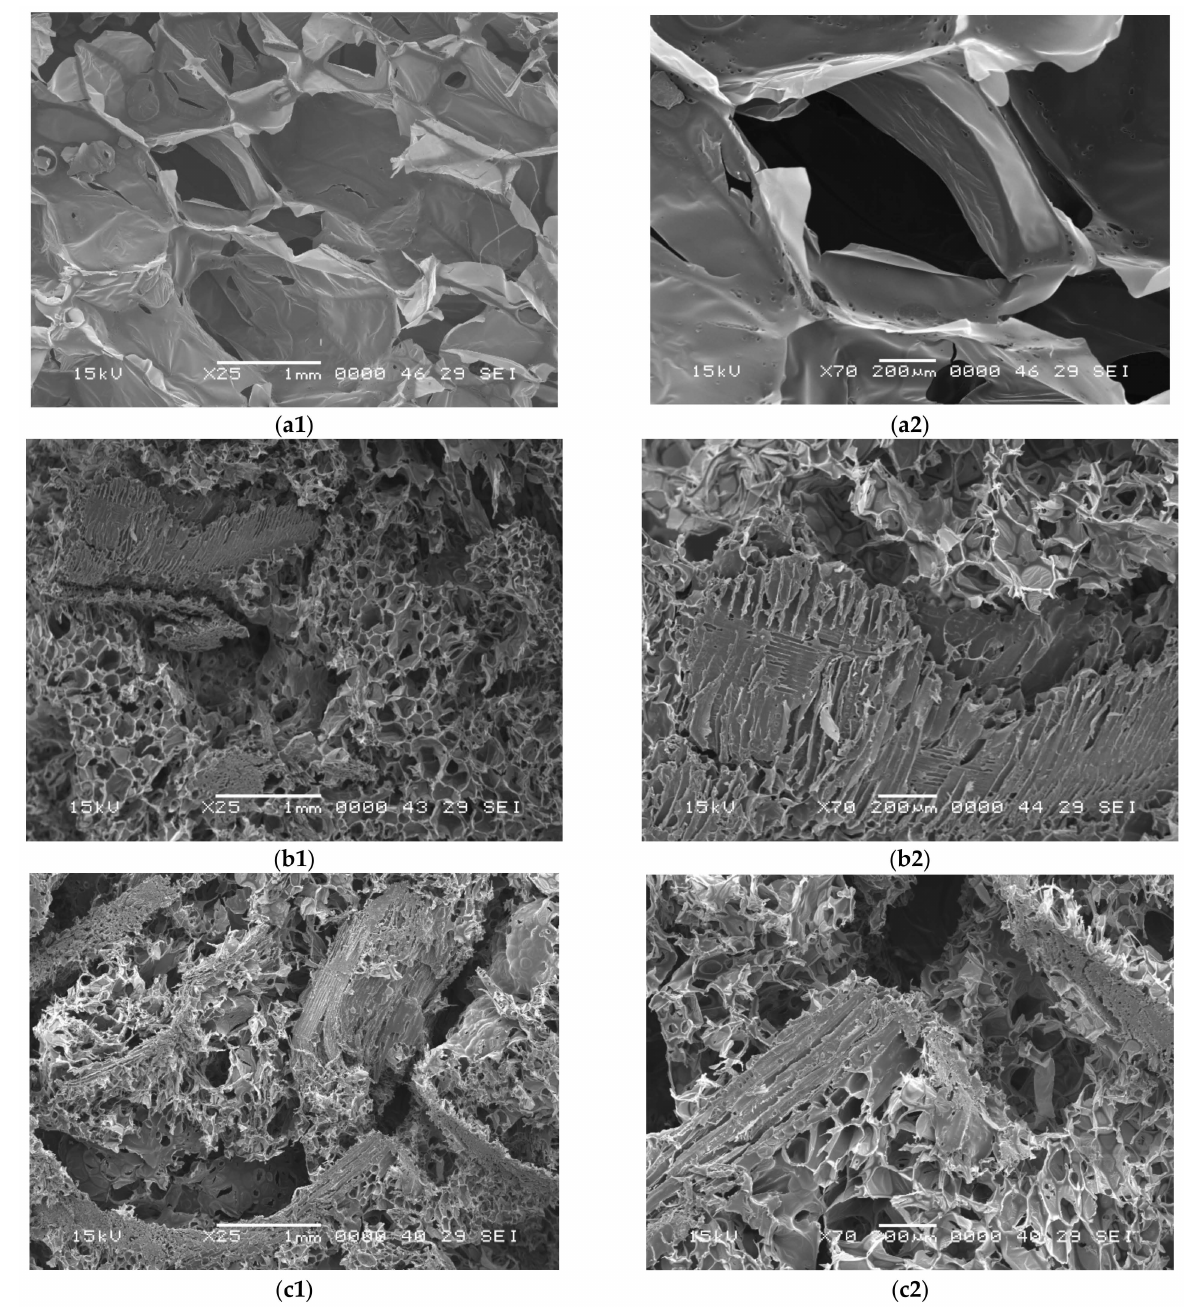
Figure 4. SEM images of obtained plates: ( a1 , a2 ) FPUF-FS0-40. ( b1 , b2 ) FPUF-FS35-40. ( c1 , c2 )